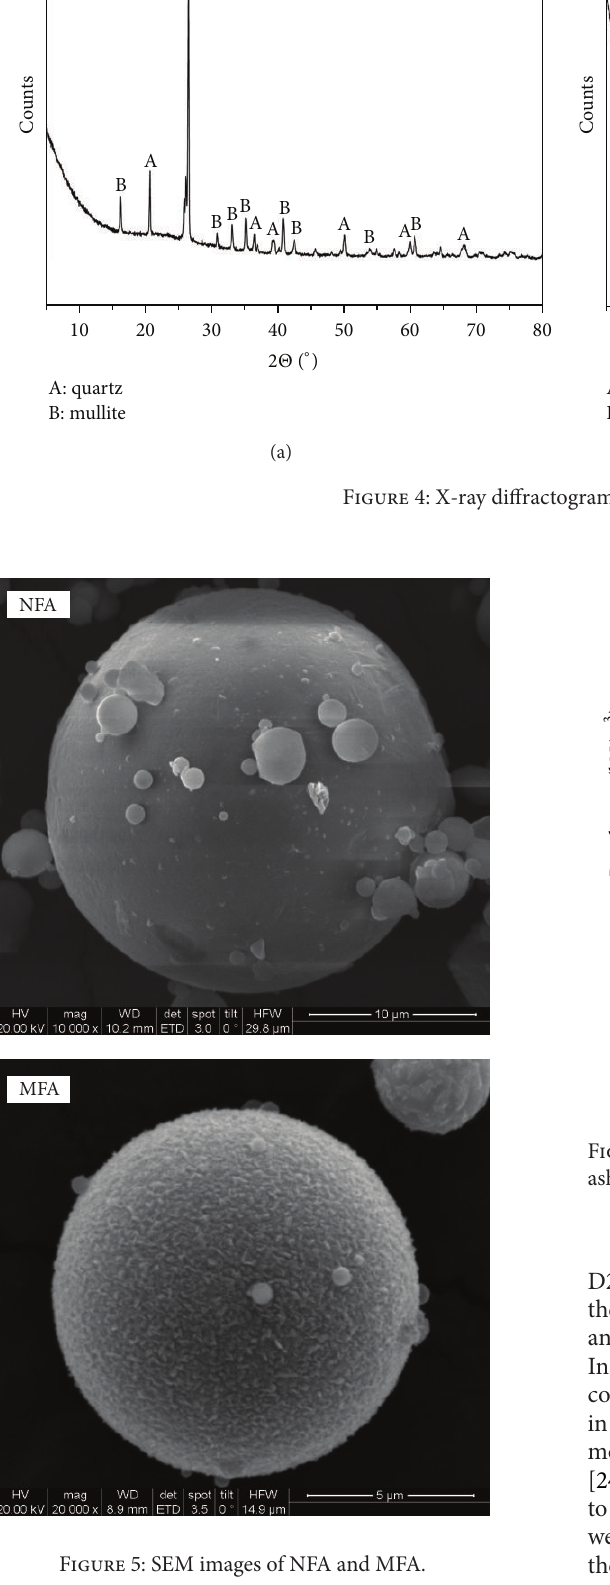
Figure 5: SEM images of NFA and MFA.